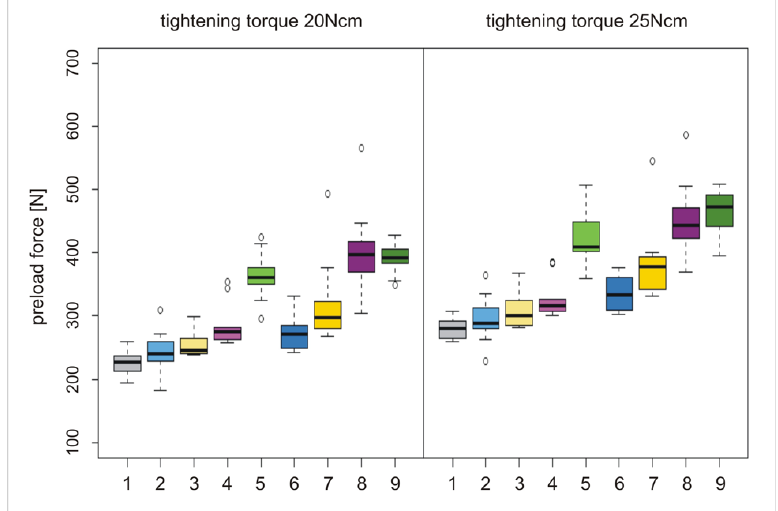
Figure 5. Boxplots of groups CG, TG1a – d, and TG2a – d with preload forces at a torque force of 20 Ncm, ( left ); boxplots of groups CG, TG1a – d, and TG2a – d with preload forces at a torque force of 25 Ncm ( right ).